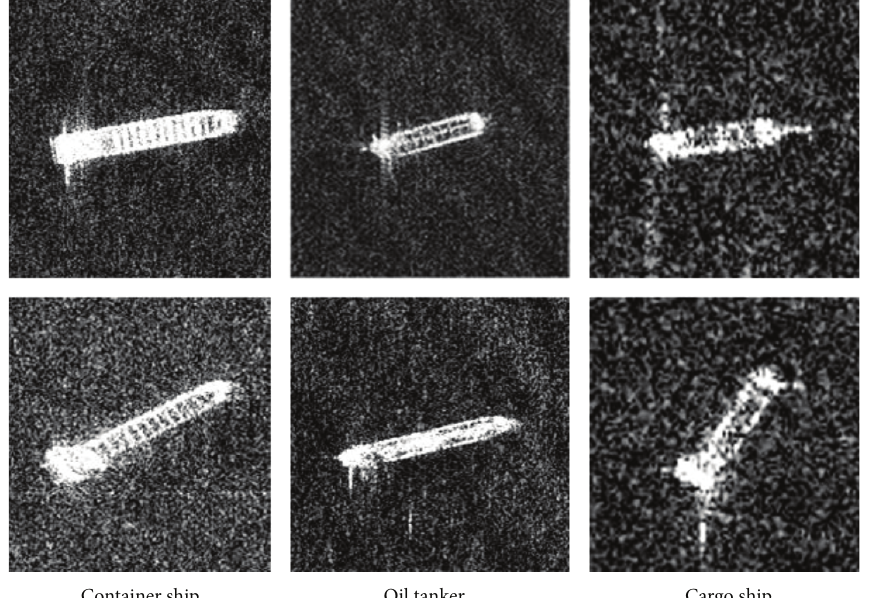
Figure 4: Samples of ship